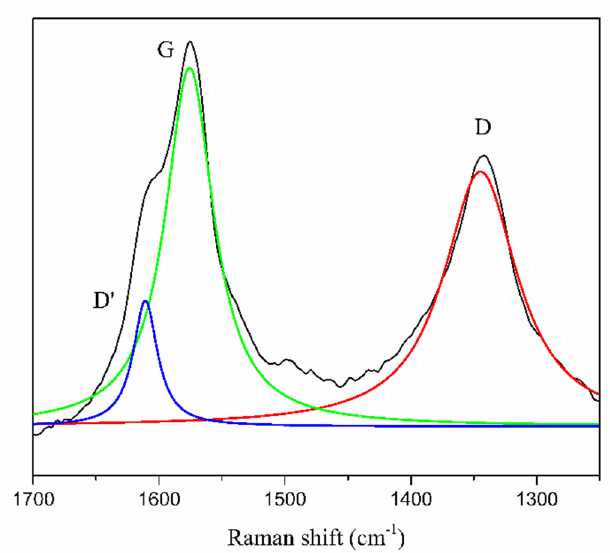
Figure 5. Deconvolution of the G and D bands in the pyr -CNOs Raman spectrum.